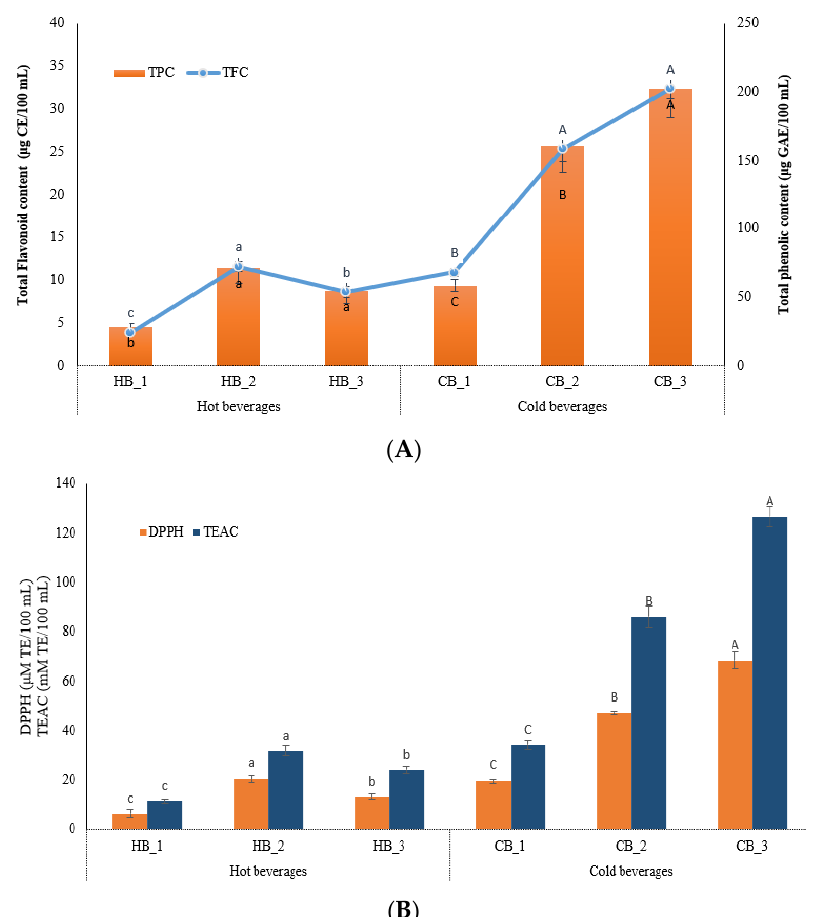
Figure 1. Nutraceutical characteristics of hot- and cold-brewed beverages. ( A ) Bioactive components, including total flavonoid content (TFC) (μg CE/100 mL) and total phenolic content (TPC) (μg GAE/100 mL), ( B ) antioxidant activities, including DPPH radical scavenging activity (μM TE/100 mL) and TEAC (mM TE/100 mL). HB_1, hot beverage 0.8 g/100 mL; HB_2, hot beverage 2 g/100 mL; HB_3, hot beverage 4 g/100 mL; CB_1, cold beverage 25 g/L; CB_2, cold beverage 50 g/L; CB_3, cold beverage 75 g/L; CE, catechin equivalent; GAE, gallic acid equivalent; TE, Trolox equivalent. The different small letters indicate significant difference between the hot-brewed beverages and the different capital letters indicate significant difference between the cold-brewed beverages ( p <